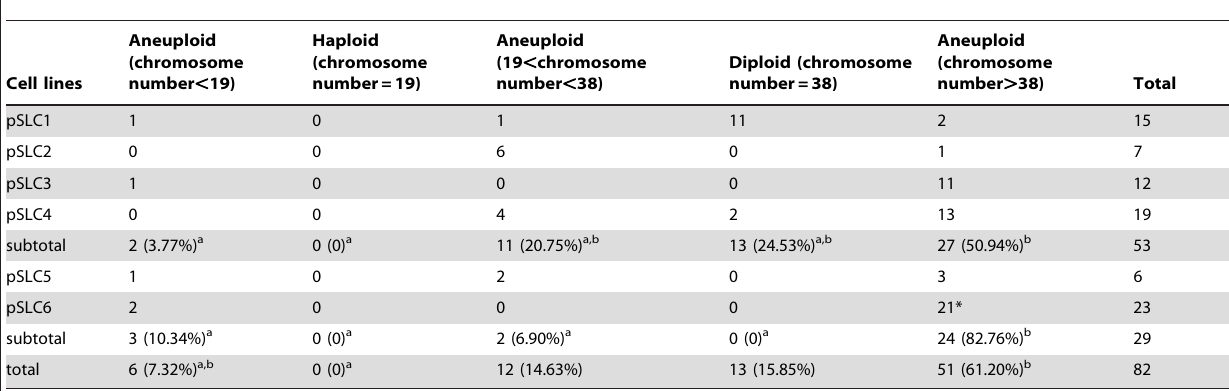
Table 2. Chromosome spread of stem-like cell lines derived from ICMs and whole blastocysts.